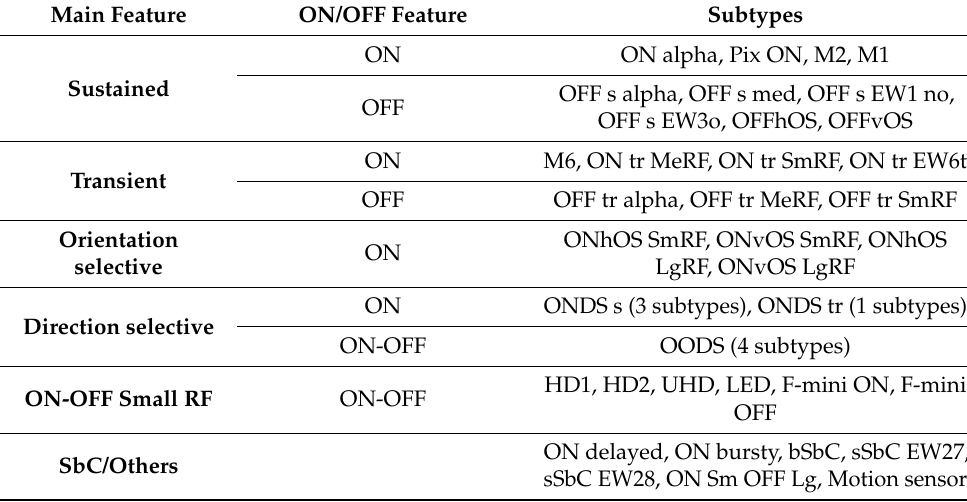
Table 1. General classification of RGC subtypes. RGC subtypes classification based on